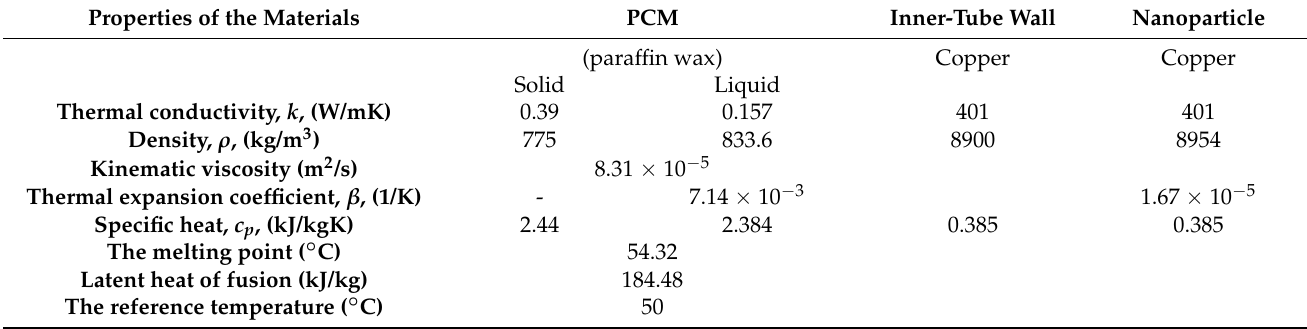
Figure 2. Different cases were considered for N (number of waves in the shell) in this study. Paraffin wax is employed as the phase change medium, and copper nanoparticles are utilized to increase the thermal conductivity of the PCM. The thermophysical characteristics of paraffin wax and copper nanoparticles are summarized in Table 1. Table 1. Thermophysical proprieties of (PCM), inner-tube wall, and Copper nanoparticles. Data from